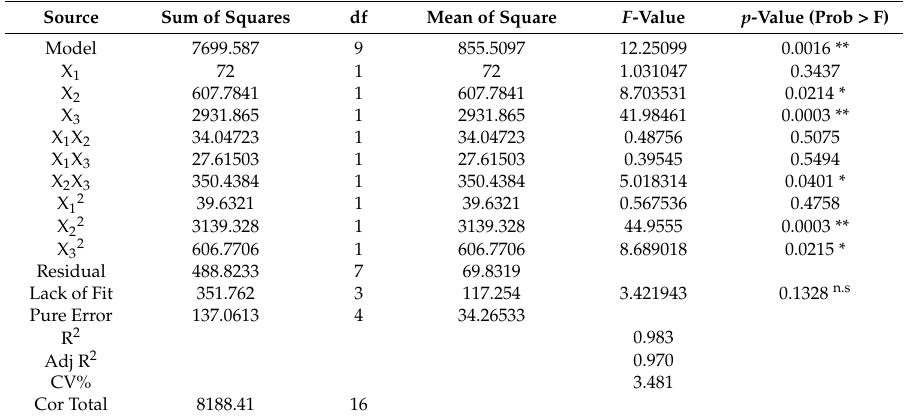
Table 2. The analysis of variance for the experimental results of α -mangostin content from mangosteen pericarp extracts.